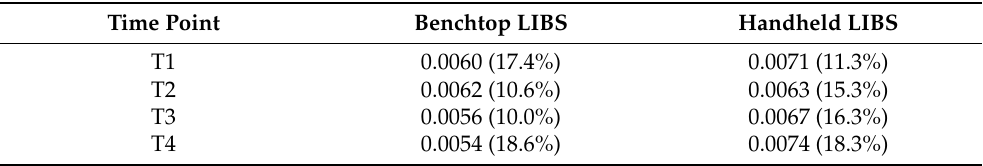
Figure 6. Averaged raw LIBS spectra of cheese samples measured on four different dates using the benchtop LIBS system. Note that every measurement was conducted every two weeks. Table 2. The averaged integrated intensity of emission peak Na I 589.0 nm at four different sampling time points in Frantal Emmental Cheese (C10). The values in parentheses represent the relative standard deviation